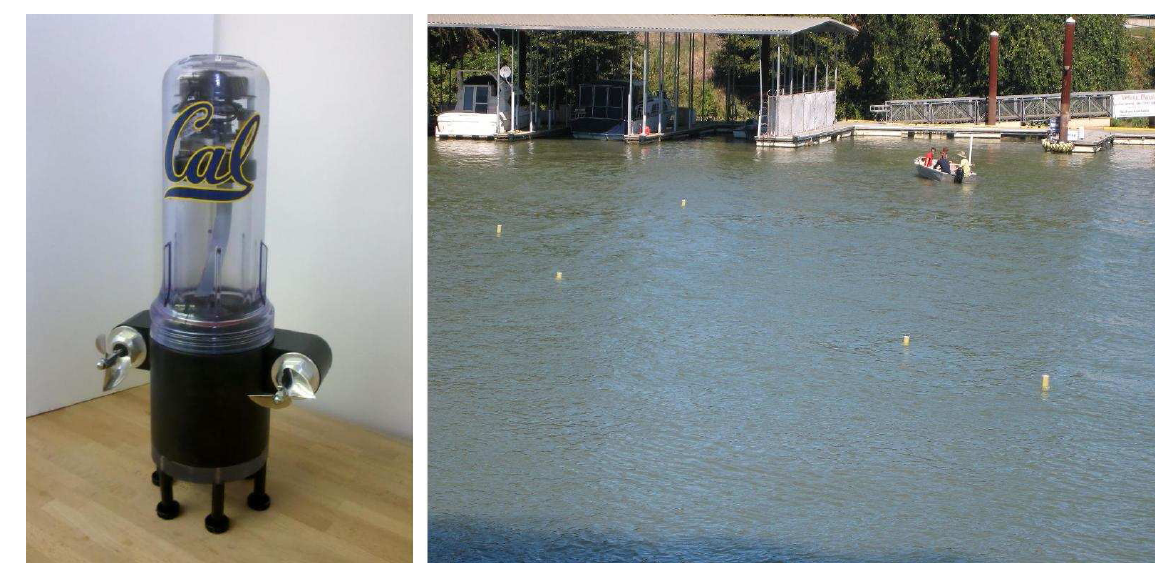
Figure 1. Prototype of a motorized drifter ( left ). Five passive drifters in a river ( right